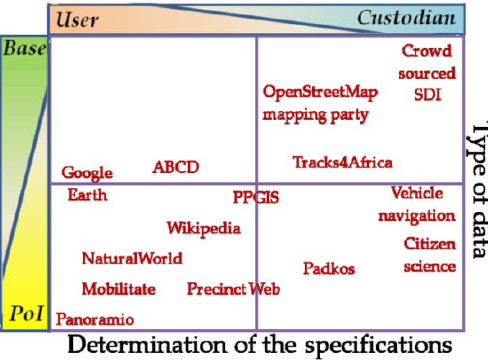
Figure 52: From Cooper (2011). African based 2D